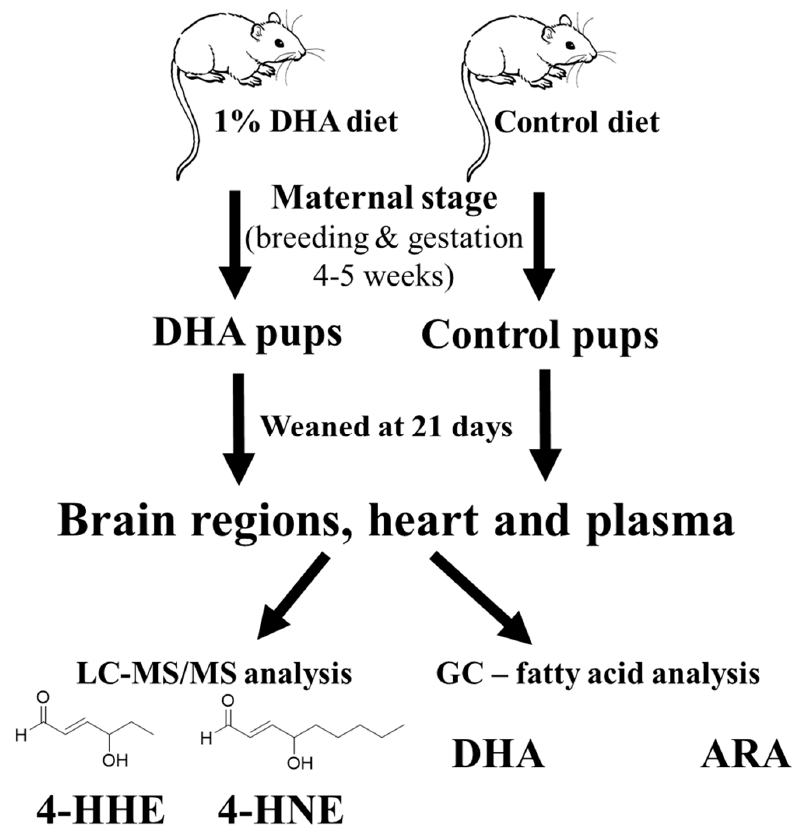
Figure 1. A scheme depicting the experimental protocol for 1% docosahexaenoic acid (DHA) and control diets to pregnant mice.